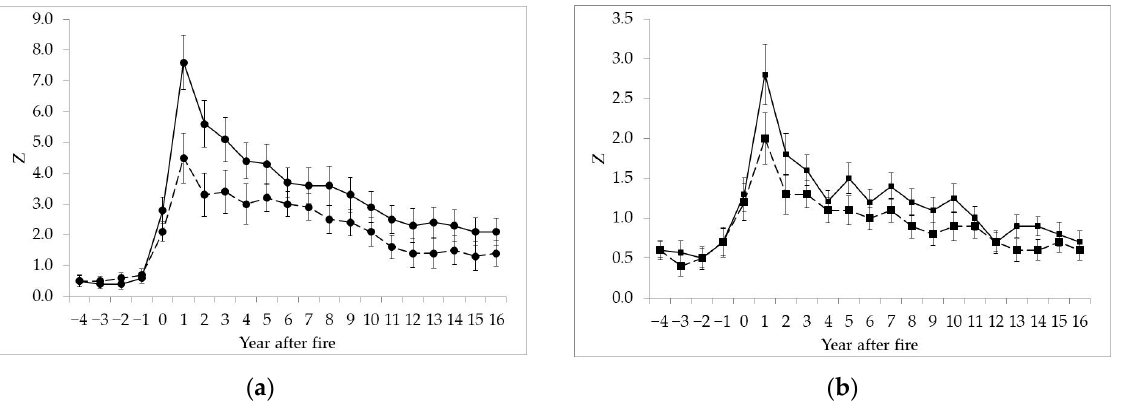
Figure 3. Post-fire dynamics for ( a ) NBR and ( b ) NDVI. Solid lines correspond to severely disturbed areas, while dashed lines show moderately disturbed areas. Error bars correspond to one standard deviation.